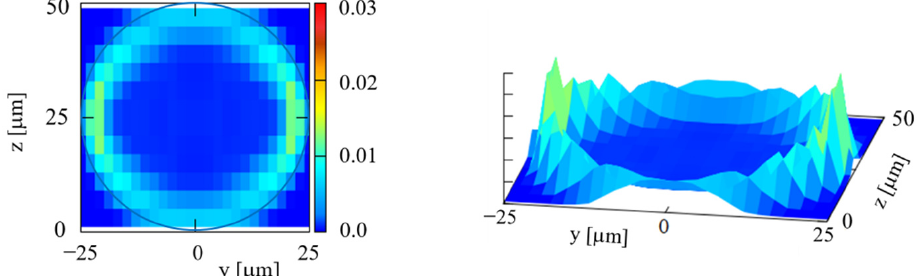
Figure 7. 2D distribution of particles over the circular cross-section at Ht = 20%.